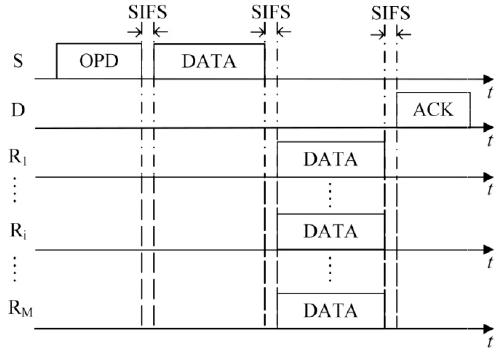
Figure 6. Data packet transmission phase.